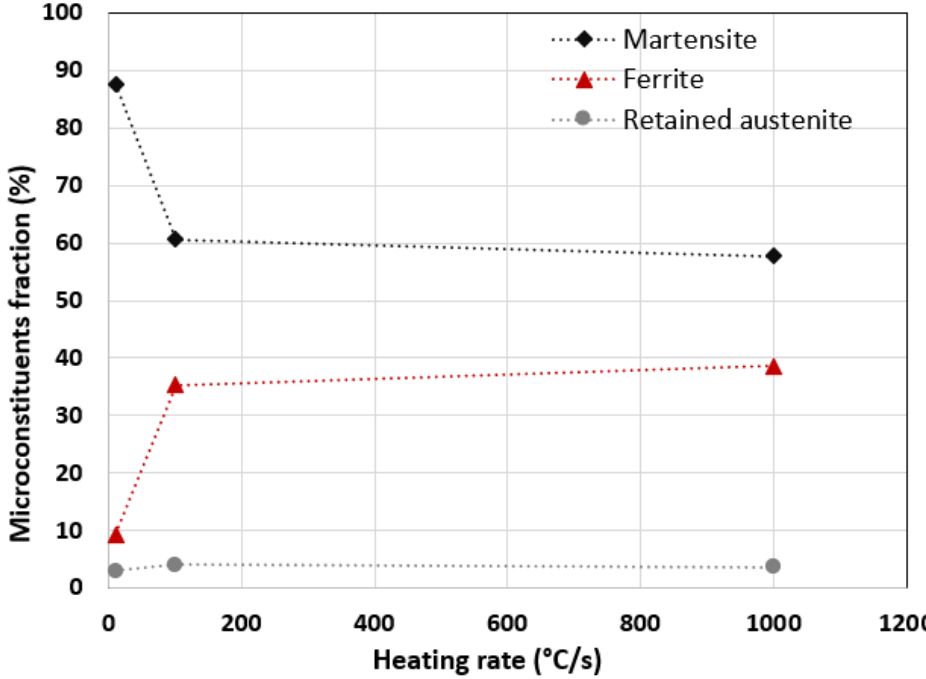
Figure 13. Microstructural evolution at different HRs for peak temperature at 902 °C (data from [57]; steel chemical composition: 0.2% C).